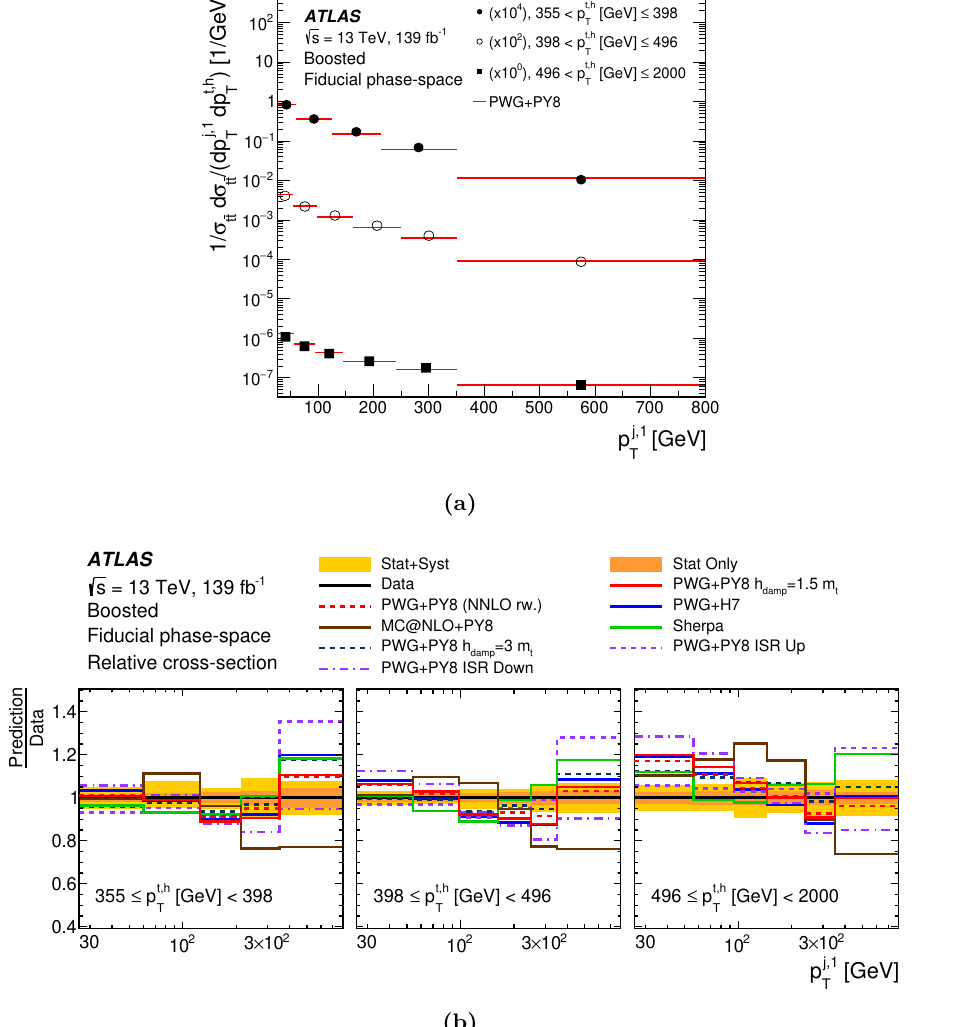
of the Figure 27. (a) Normalised differential cross-section measurements as a function of the p T leading additional jet in bins of p t,h are compared with the prediction from the Powheg+Pythia T MC generator. The measurement and the predictions are further normalised by the factors shown in parentheses to aid visibility. (b) Ratio of the measured normalised cross-section to different NLO, and NLO reweighted to NNLO, predictions of t ¯ t signal for the same differential variables. PWG+PY8 corresponds to the Powheg+Pythia sample, PWG+H7 to the Powheg+Herwig sample and MCatNLO+PY8 to the MadGraph5_aMC@NLO+Pythia sample. The yellow band represents the total uncertainty of the measured differential cross-section while the orange band shows the statistical